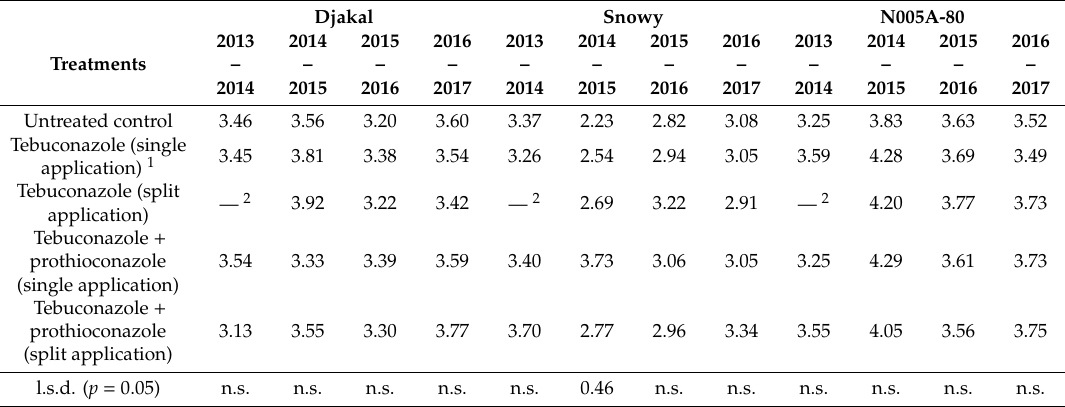
Table 3. Fungicide treatment e ff ects on soybean grain yield (t / ha) for three cultivars in four years of field experiments at Leeton Field Station, New South Wales.